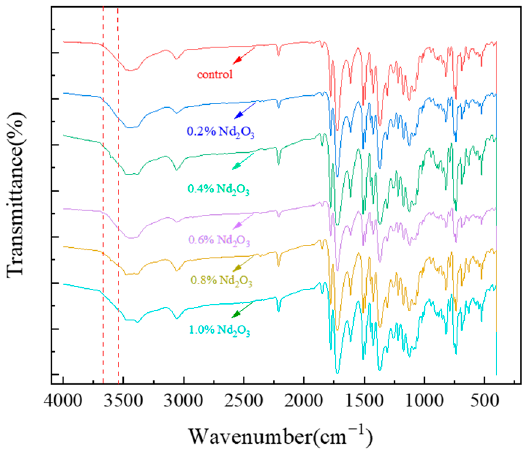
Figure 3. The FTIR spectra of the imide oligomers with different Nd 2 O 3 content.